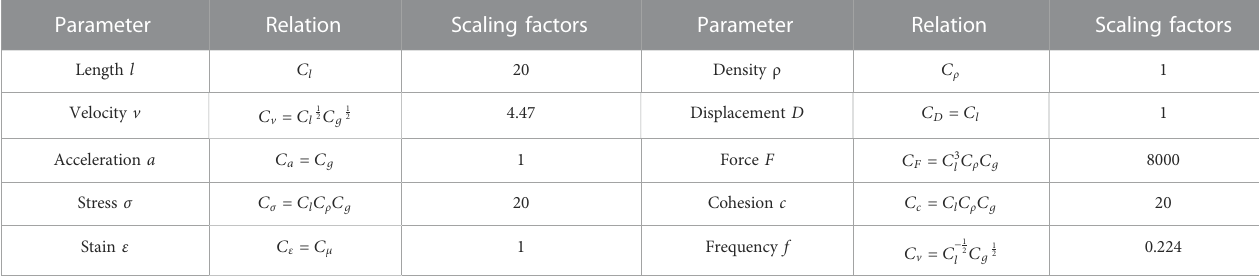
TABLE 1 Parameter scaling factors for the model